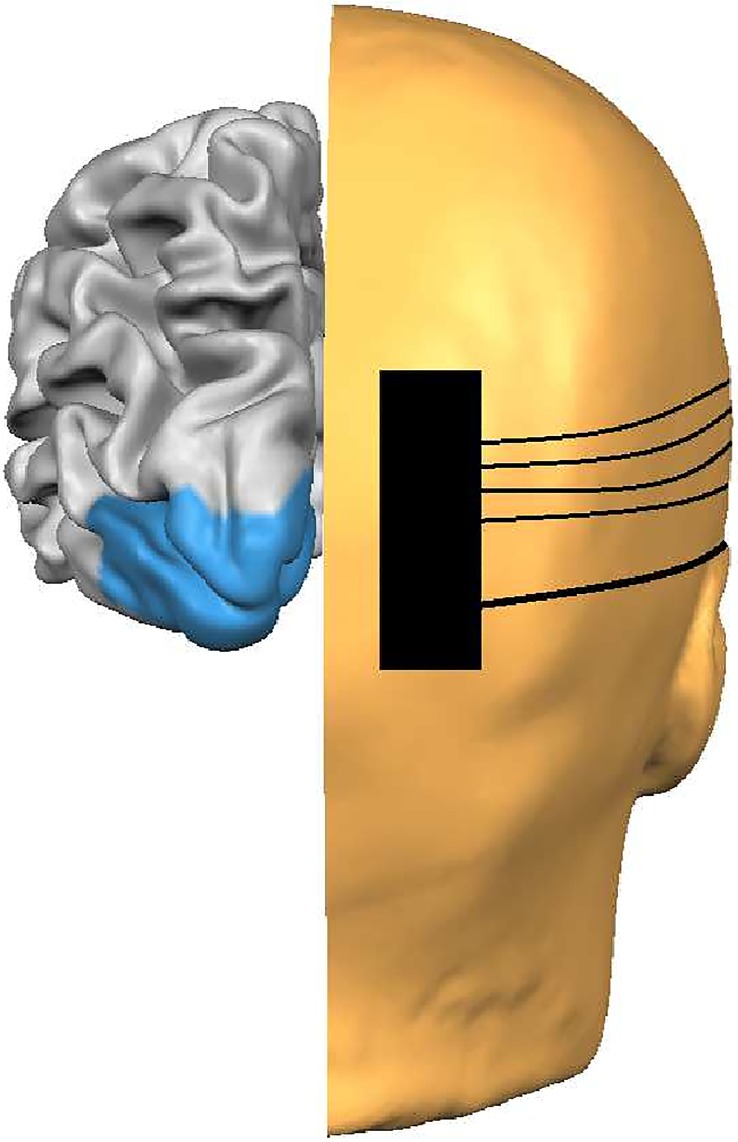
Diagram of fNIRS set-up with the sensor placed over O2 (right hemisphere, 10–20 EEG system).All recordings were taken from over both right (O2) and left (O1) primary visual cortices (blue region).